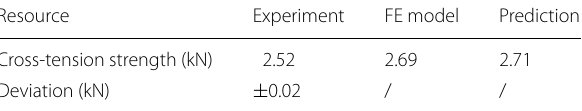
Table 6 Comparison of the cross-tension strength from experiment, FE model and the prediction model